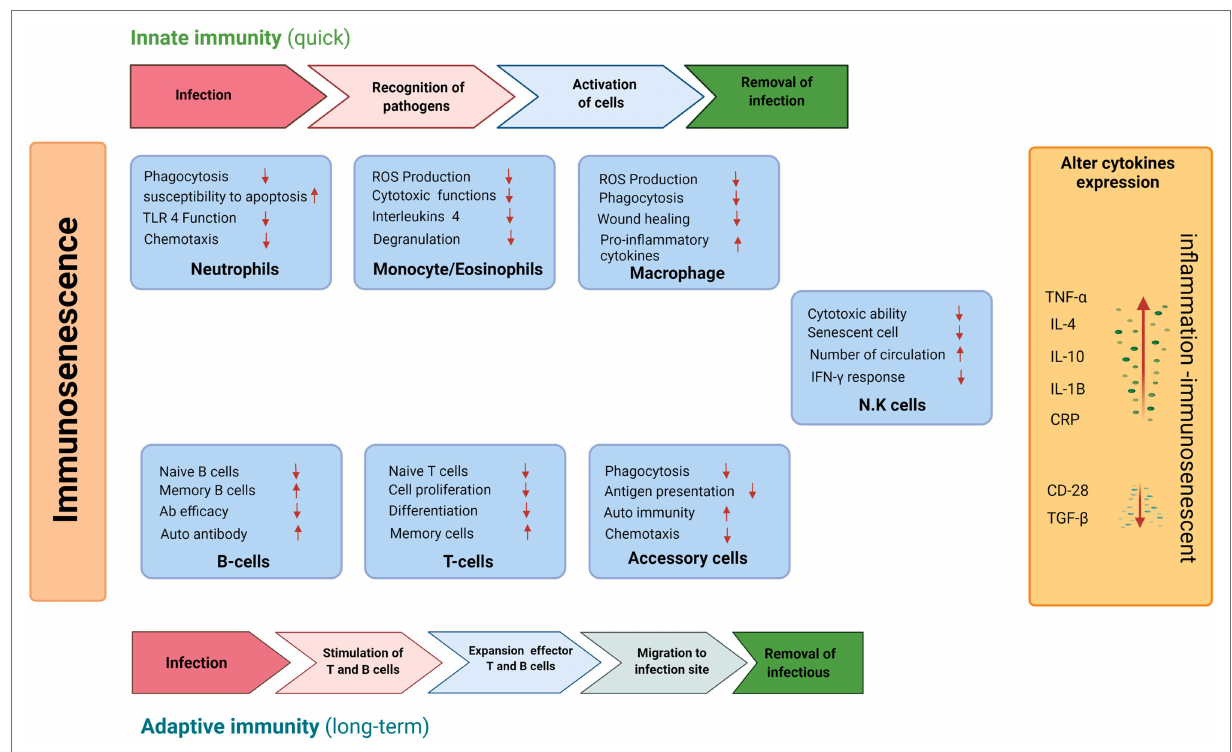
FIGURE 2 | Schematic representations of age-related changes in the innate and adaptive immune system during aging in inactive